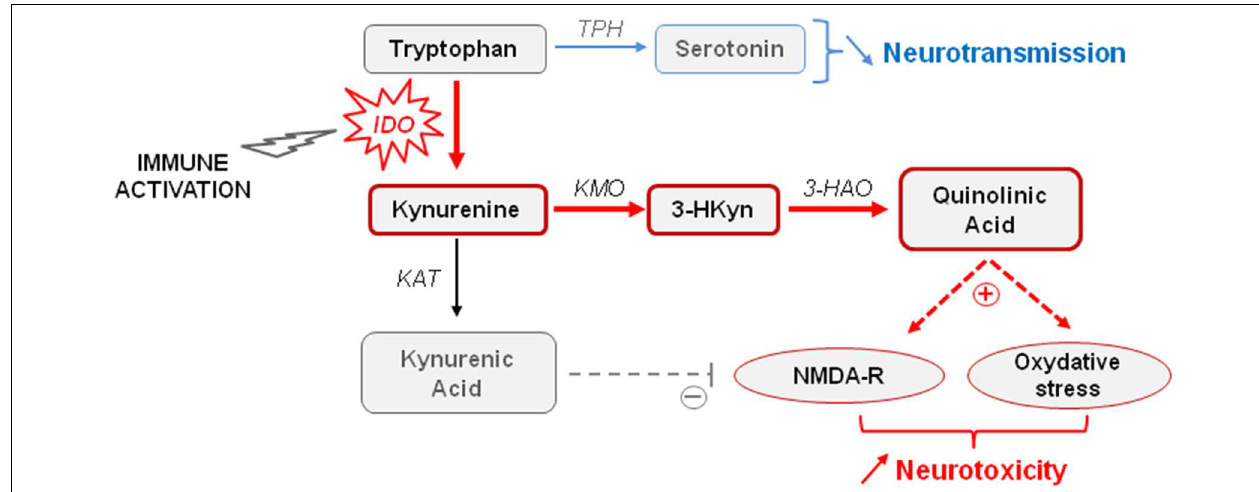
FIGURE 1 | Tryptophan metabolism through the kynurenine pathway. Increased indoleamine 2,3-dioxygenase (IDO) activity occurring in activated monocytes, macrophages, and brain microglia in conditions of immune activation catabolizes tryptophan in kynurenine. Tryptophan is the biosynthetic precursor for the synthesis of serotonin. By reducing the availability of tryptophan for serotonin synthesis, IDO activation is able to impair serotonin neurotransmission. Kynurenine is metabolized in different neuroactive glutamatergic metabolites, including 3-hydroxykynurenine